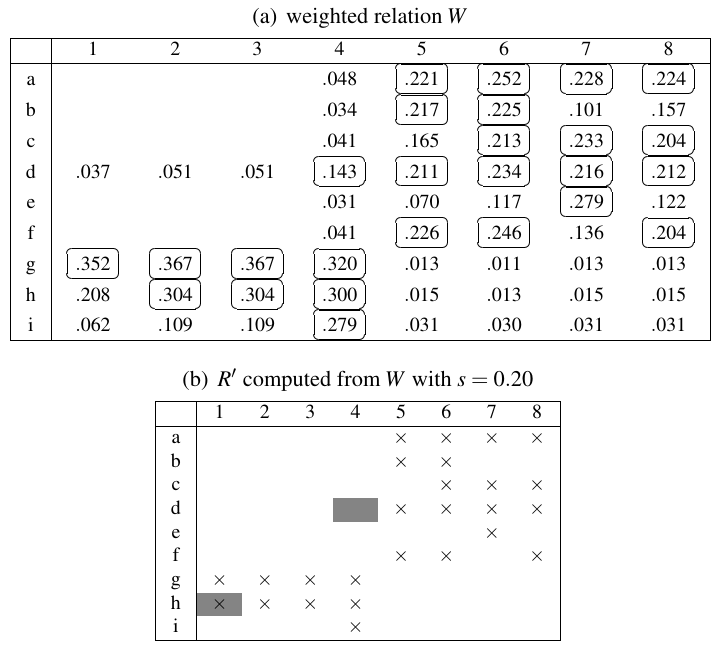
Table 1: Modification of the relation permit to go from 13 to 11 concepts